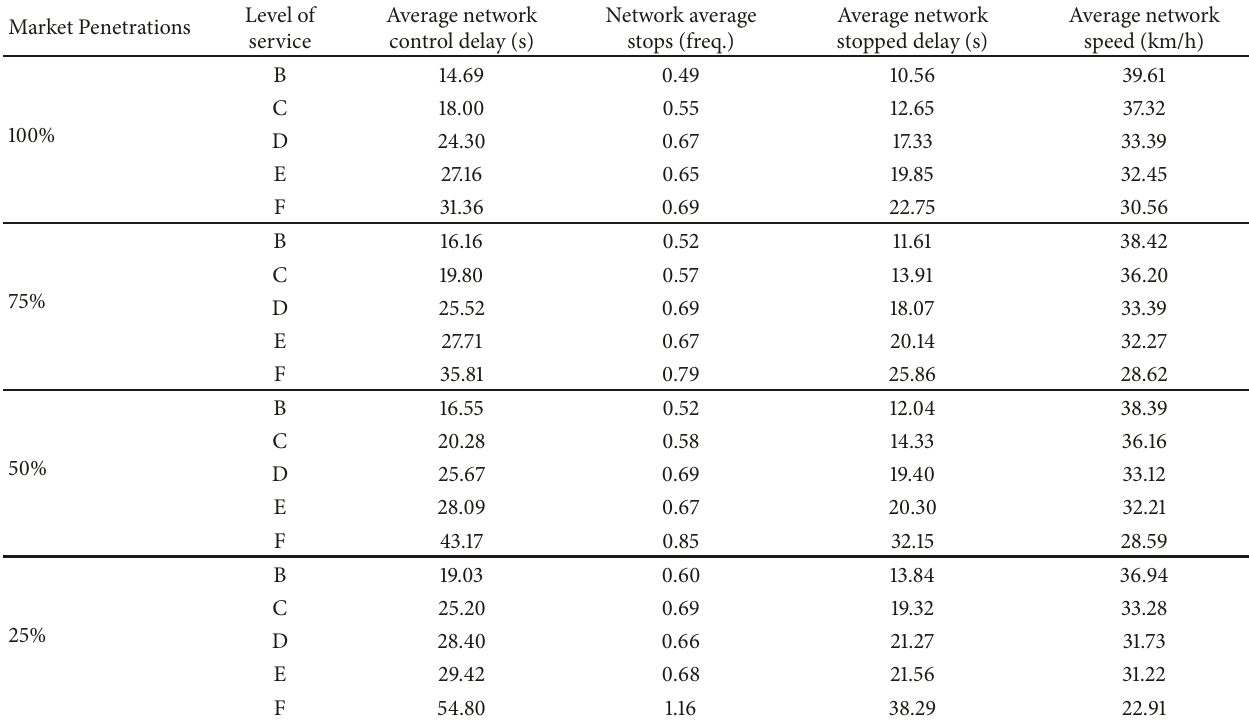
Table 4: Simulation results with different market penetration